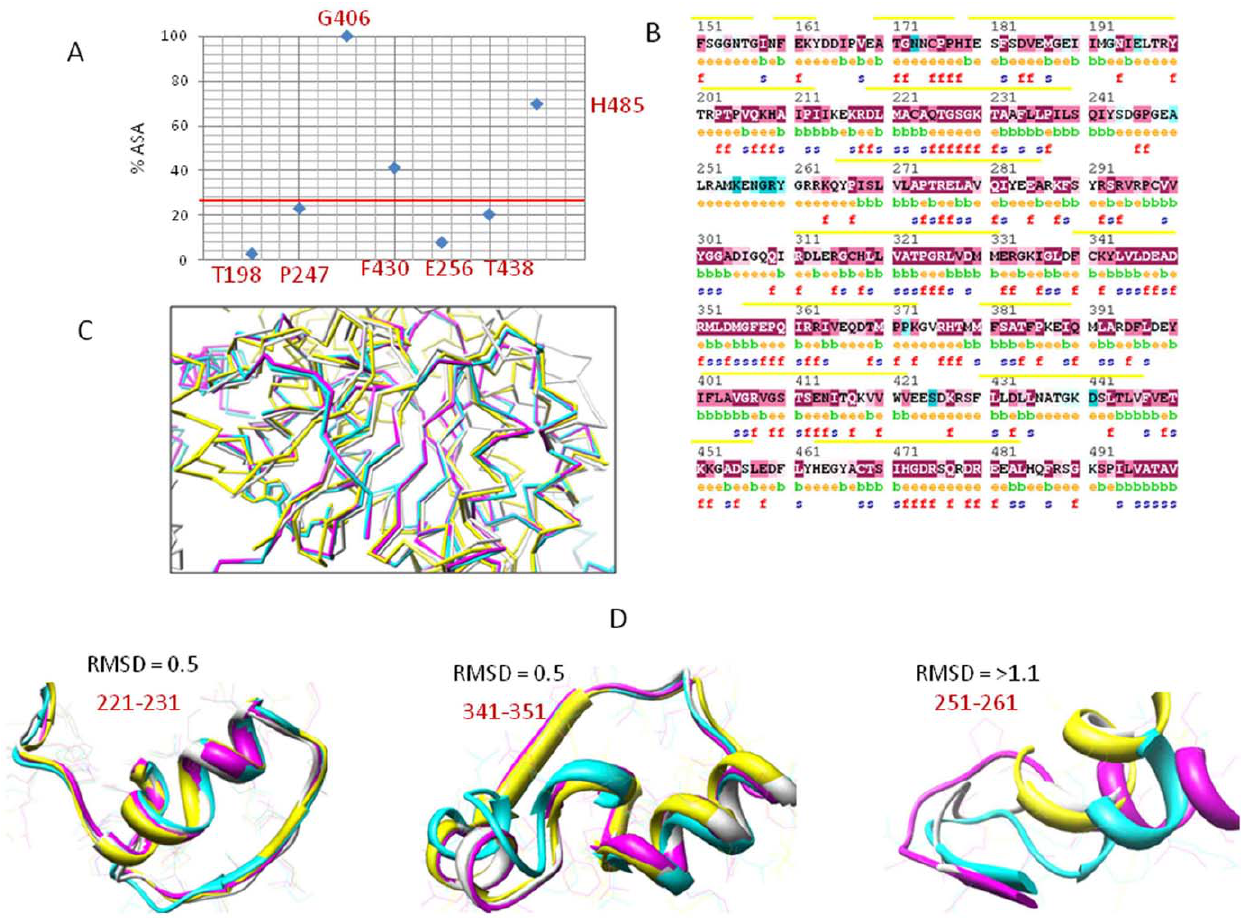
Figure 2. Functional residue identification on DDX3X. A) Positively selected residues plotted against Accessible Surface Area (ASA) B) Residues under negative selection (yellow line) grouped into functional amino acids based on conservation scores. The numbering corresponds to amino acid positions in DDX3X. f: functional residues; s: structural residues; e: exposed; b: buried C) Graph between Root Mean Square Deviation (RMSD) and residue position represents structural alignment of DEAD box members. D) DDX3X structurally aligned with DEAD box